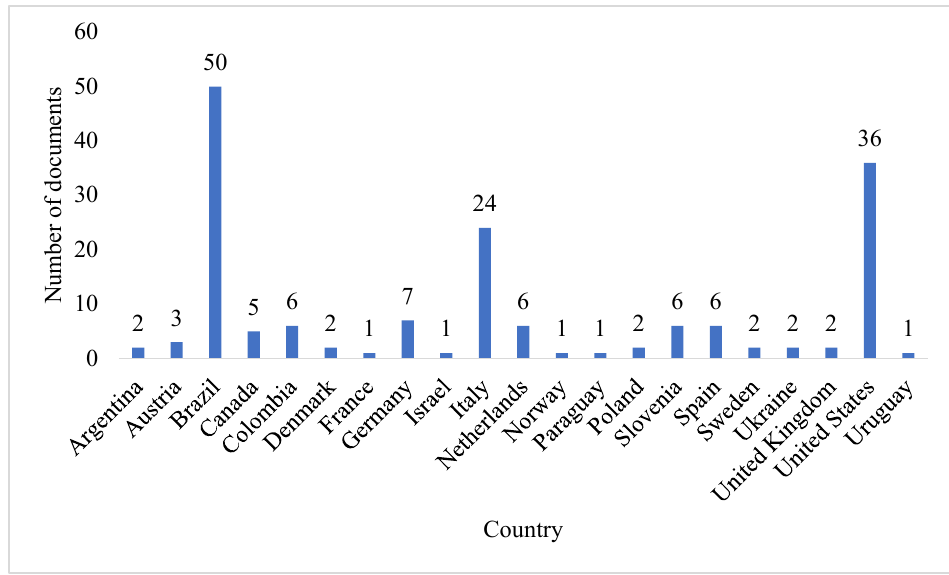
Figure 4. Number of publications by country.